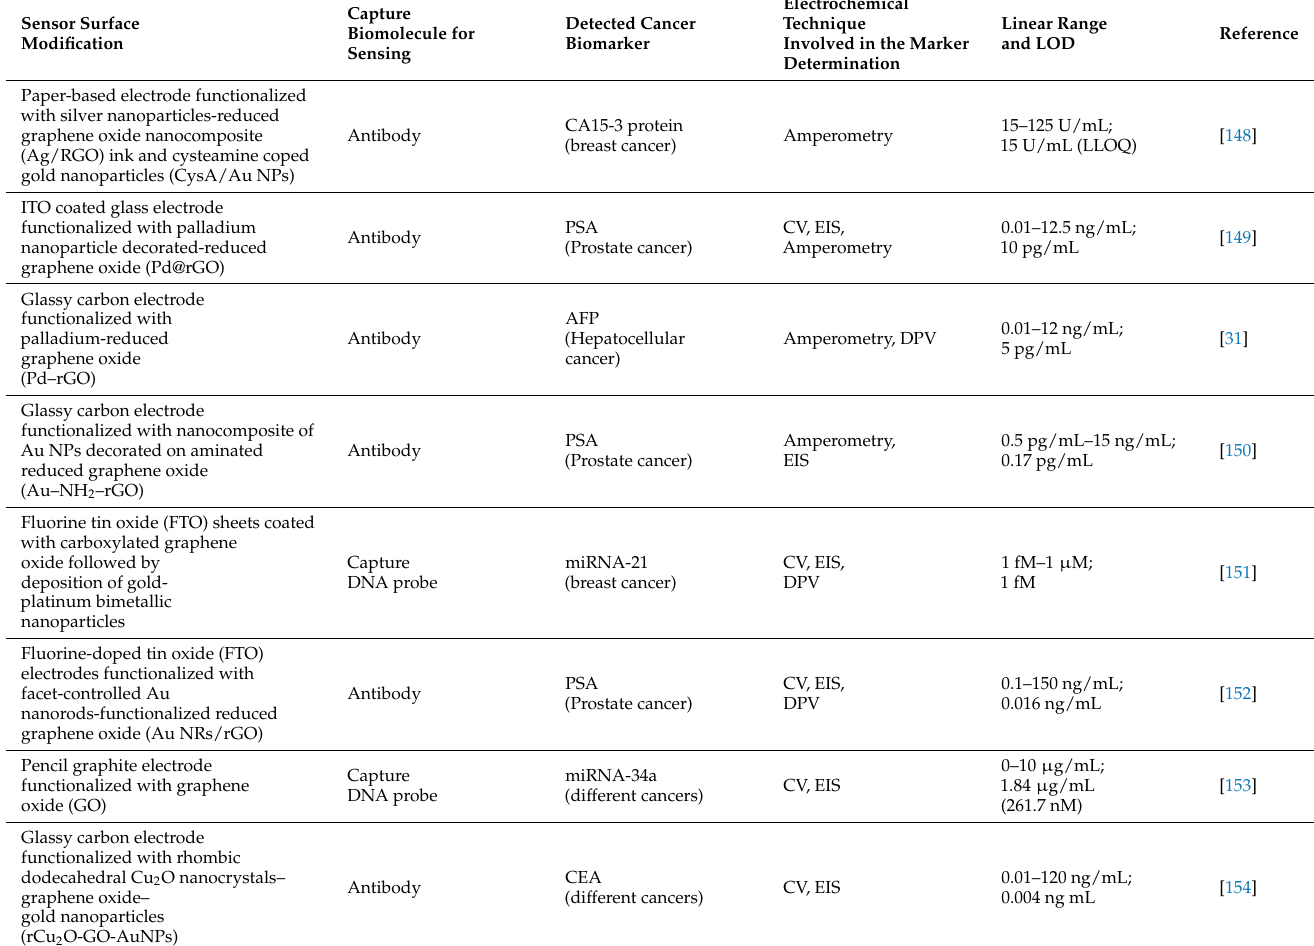
Table 2. Label-free graphene oxide-based electrochemical biosensors for cancer